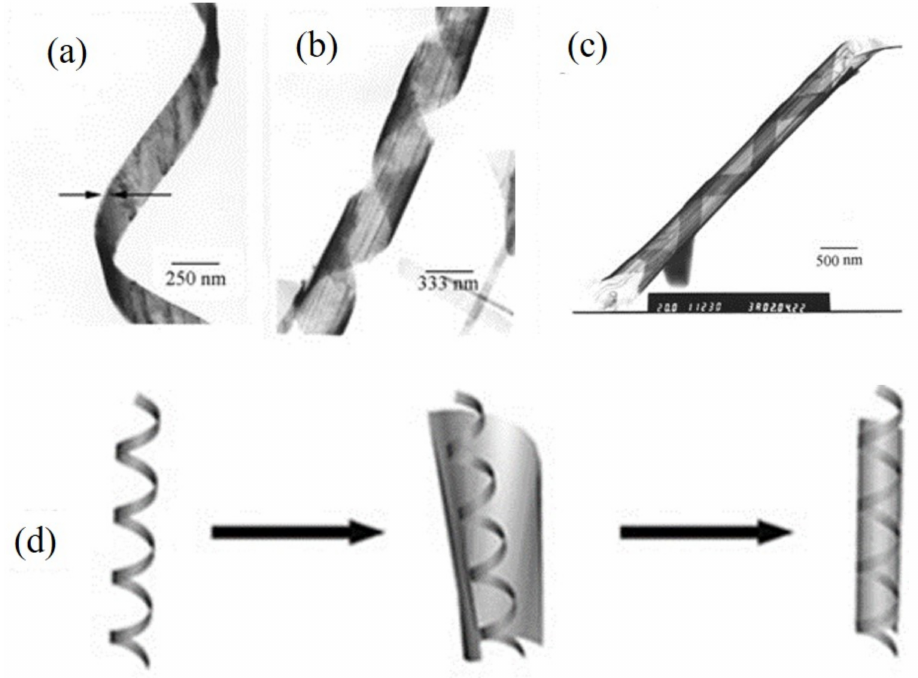
Figure 7. ( a – c ) Representative TEM images of the as-synthesized Te NBs and NTs, showing their geometric shapes. ( a ) Twisted Te nanobelt. ( b ) Helical nanobelt, displaying the helical twisting property of the NBs. ( c ) A typical belt-rolled Te nanotube. ( d ) Schematic illustration of the proposed HBT mechanism. Reprinted with permission from [38]. Copyright 2002, WILEY-VCH Verlag GmbH & Co. KGaA,